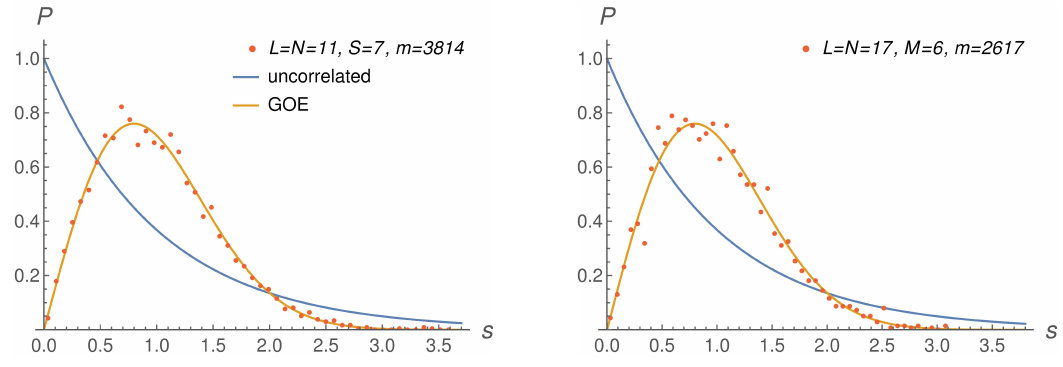
Figure 3: Distribution of spacings for different sectors of N = 4 SYM at N = L , against the GOE distribution. On the left we consider the sl ( 2 ) sector, and on the right we have the su ( 2 ) sector. In both cases we focus on the positive parity sector, and clip 11% and 4% of low- and high-energy states respectively.